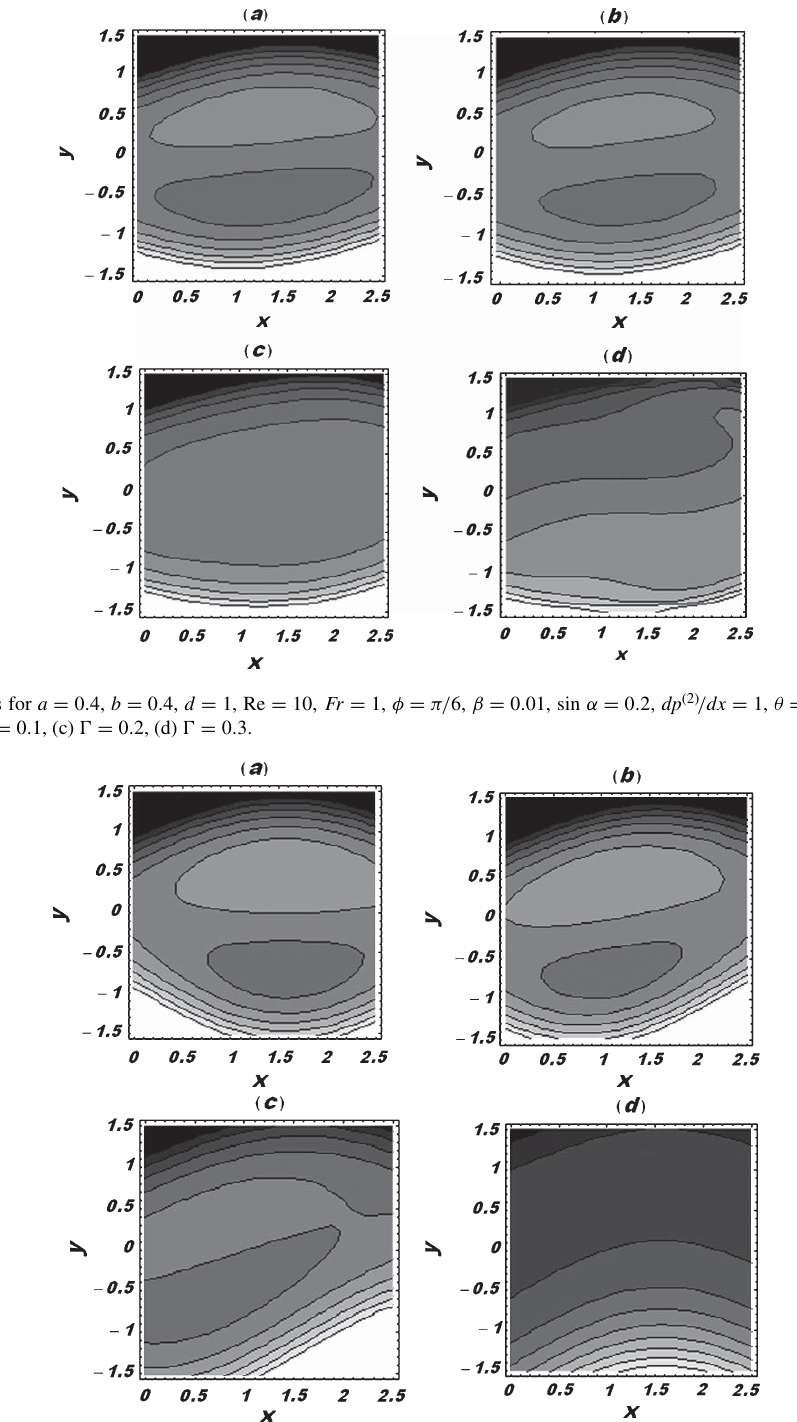
Fig. 21. Streamlines for a = 0 . 5, b = 0 . 7, d = 1, Re = 10, Fr = 0 . 6, β = 0 . 1, θ = 1 . 4, dp (2) /dx = 2, α = 0 . 2, (cid:15) = 0 . 01 with different φ (a) φ = 0, (b) φ = π/ 4, (c) φ = π/ 2, (d) φ = π